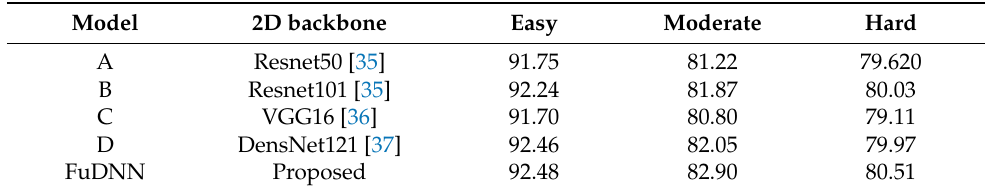
Table 4. Ablation experiments of different 2D backbones in the car class of KITTI validation set with IoU threshold 0.7.